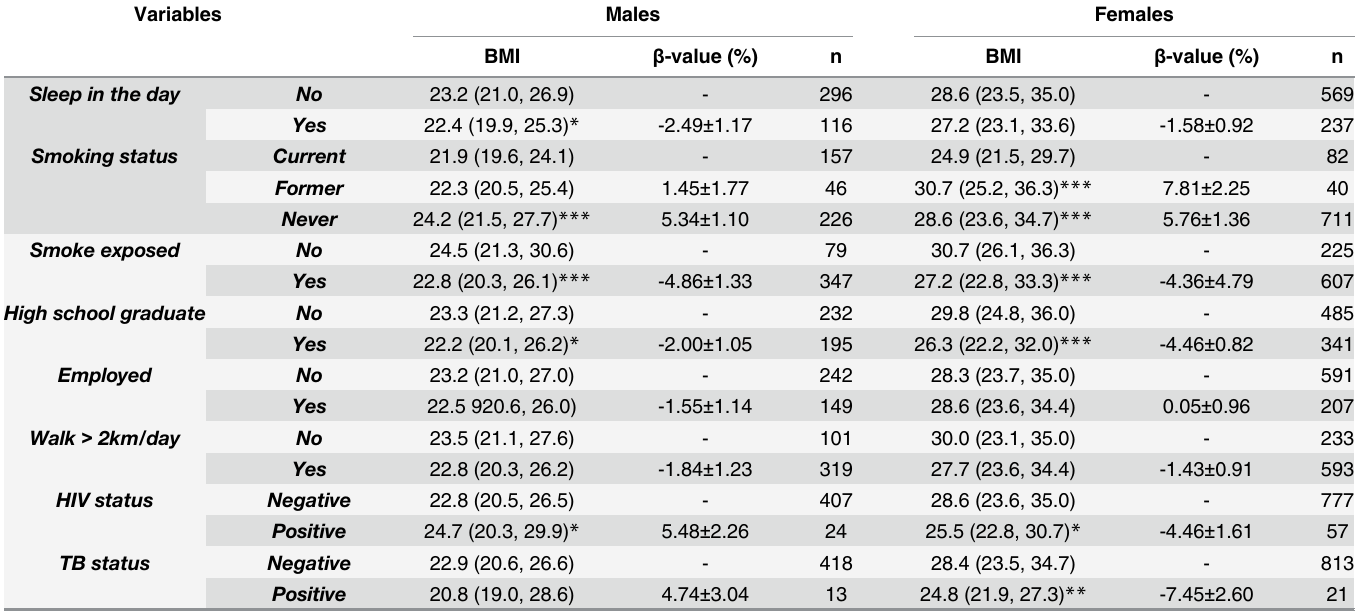
Table 2. BMI values in different population sub-groups for each gender. Variables